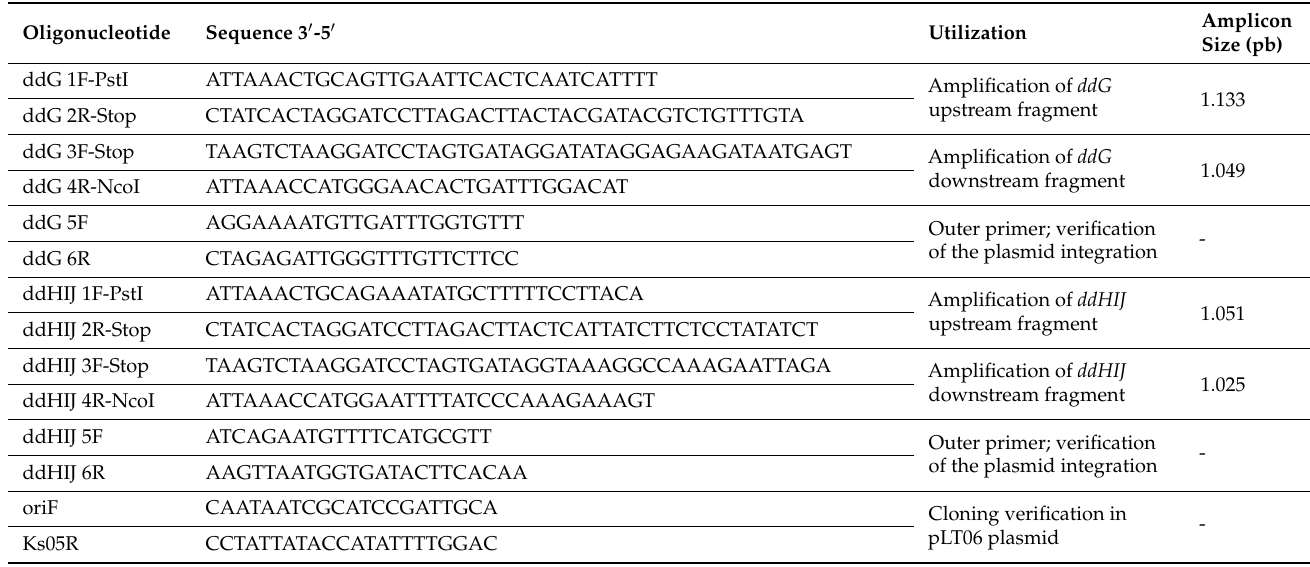
Table 2. List of oligonucleotides used in this